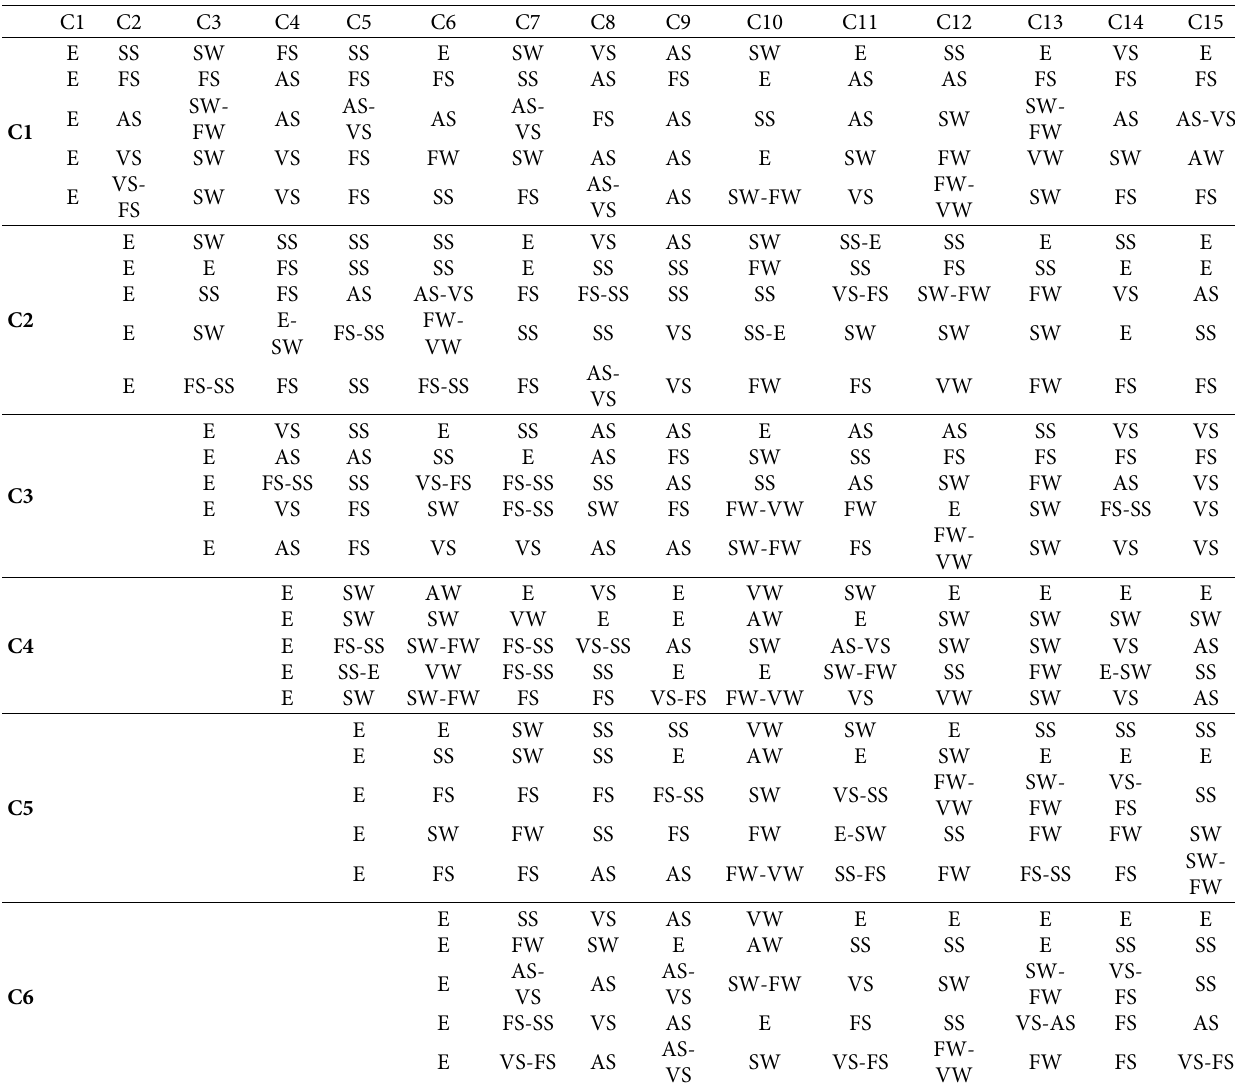
Table 4: Pairwise comparisons of criteria by 5 DMs.